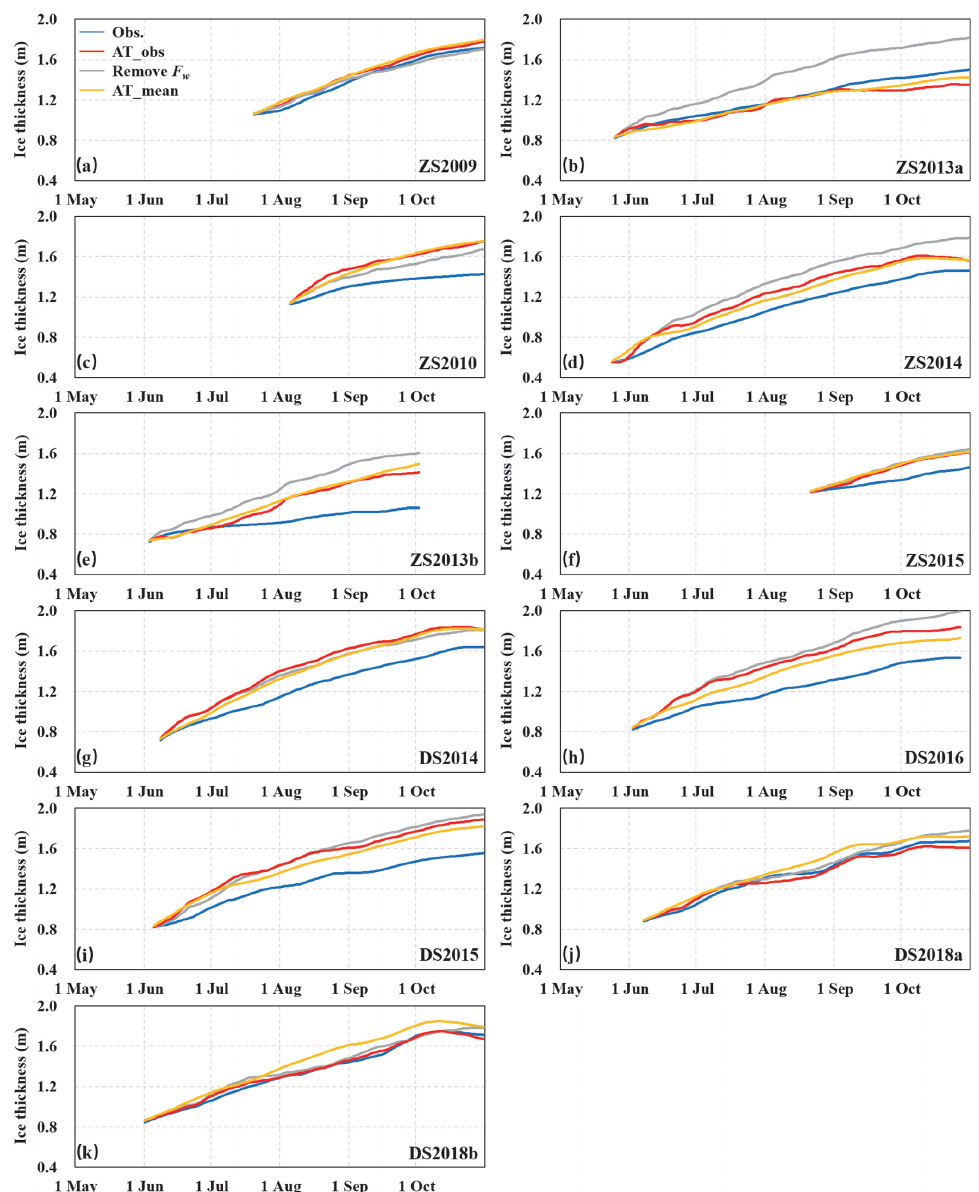
Figure 8. LFI thicknesses observed by the buoys (blue line) and calculated ignoring the oceanic heat flux (gray line), using AT_obs (red line) and AT_mean (yellow